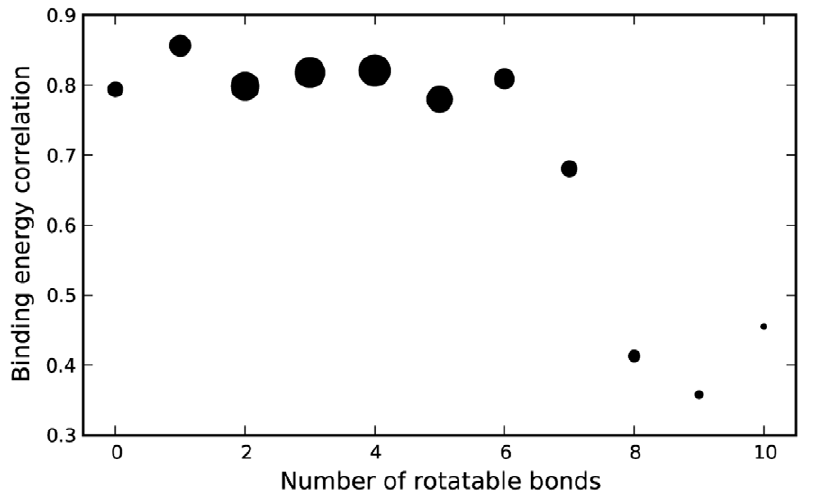
Figure 9. Correlation in scoring between AD4 and Vina. Identical conformations of DSII ligands were evaluated using AD4 and Vina. Correlations between these scores was organized by the number of rotatable bonds in the ligands, indicating increasingly dissimilar scores as the number of rotatable bonds grew. The area of each circle is proportional to the number of ligands that contained the specified amount of rotatable bonds.